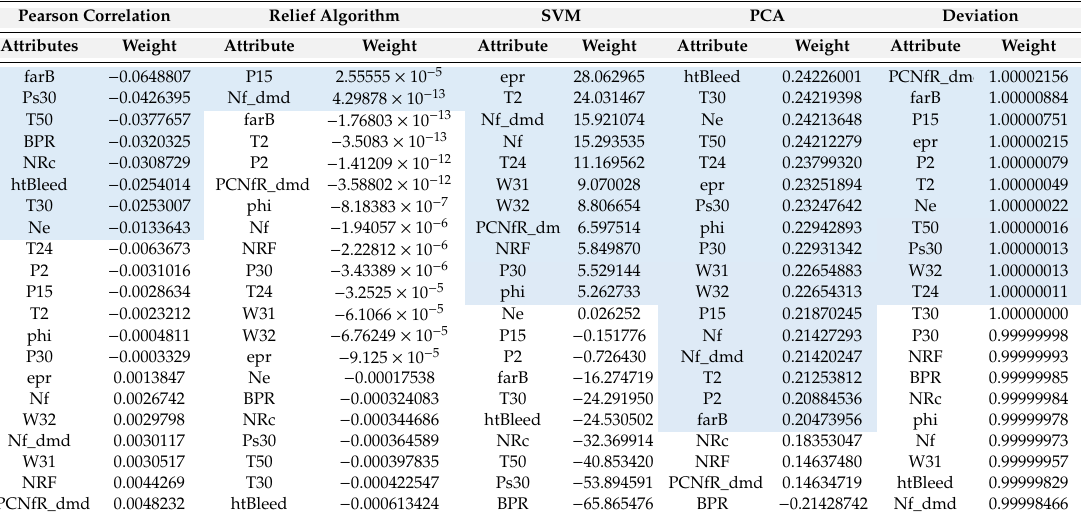
Table 3. Attribute values from di ff erent filter